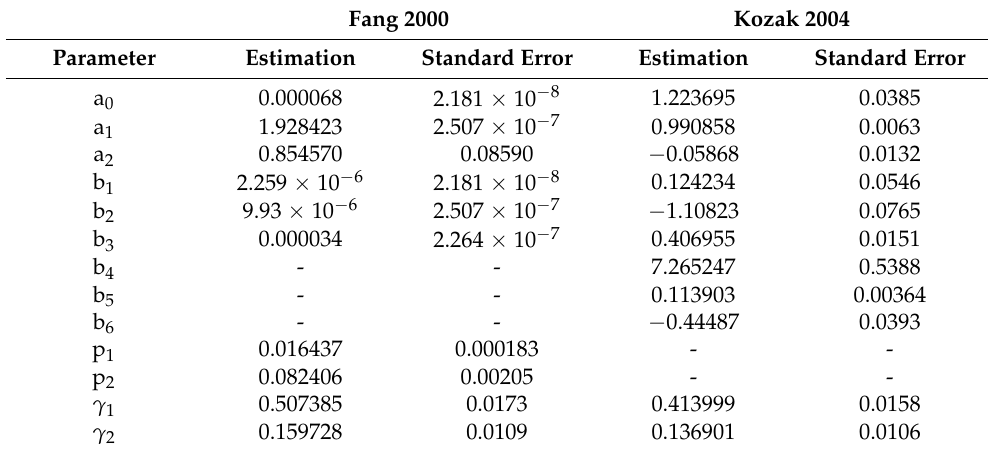
Table 5. Parameters estimated and standard errors of the conventional models of tapering